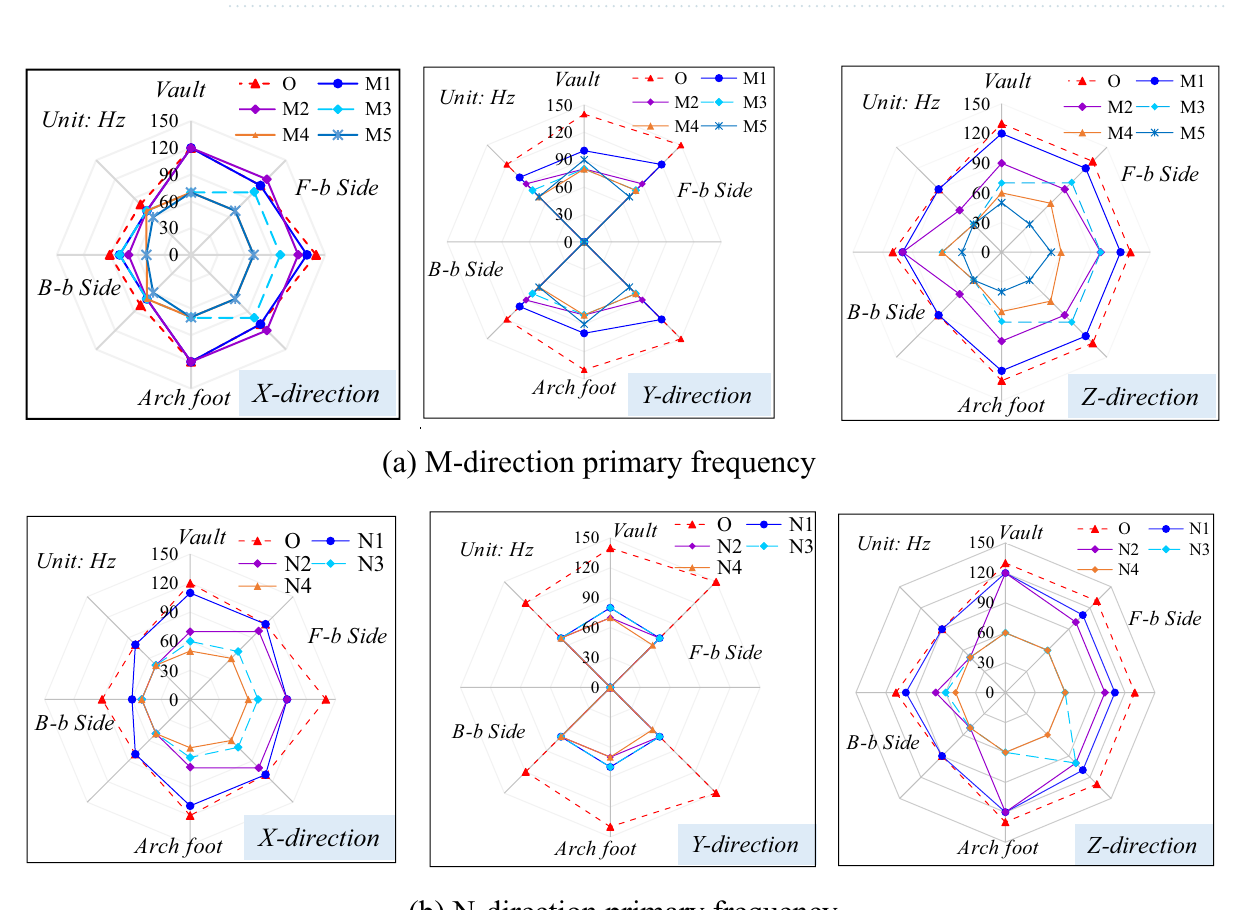
Figure 9. Primary frequency of surrounding rock vibration in adjacent tunnel ( L = 15 m, D = 10